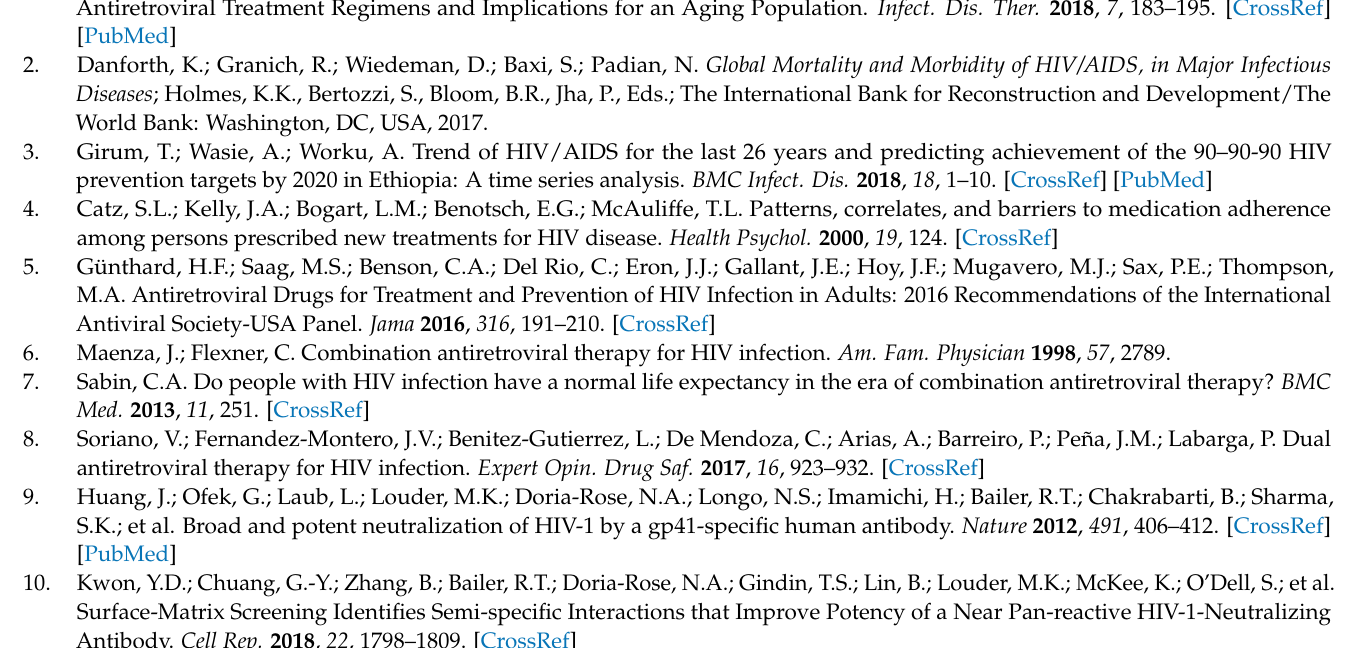
(Top row) Fo-Fc electron density maps of CDR H3 of 10E8v4 variants contoured at 3 σ . (Bottom row) 2Fo-Fc electron density maps of CDR H3 of 10E8v4 variants contoured at 1 σ . (B) Elution profiles of Superdex 200 increase 10/300 GL (GE Healthcare) size-exclusion chromatography column. (C) Neutralization potency and breadth. Figure S9: Proline to Ala mutations in the YPP motif similarly affected the potency of 10E8v4-100cW variants as the mutations affected the potency of 10E8v4. (A) The SEC profile of 10E8v4-100cW. (B) Neutralization potency and breadth of 10E8v4-100cW variants with Pro to Ala mutations. (C) Comparison of the YPP domain of 10E8v4 and 10E8VLS. Figure S10: Interaction between the YPP motif of 10E8v4 and its light chain, its binding kinetics to a gp41 scaffold and the SEC profiles of light chain variants. (A) Close-up view of the YPP motif of 10E8 in complex with gp41 peptide. (B) 10E8v4 IgG binding to gp41 scaffold, T117-F at pH 5.8 by BLI. (C) 10E8v4 IgG binding to gp41 scaffold, T117-F at pH 10.55 in the presence of 100 mM Arg by BLI. (D) SEC profiles of 10E8v4 light chain variants. Table S1: Comparison of 10E8 and its